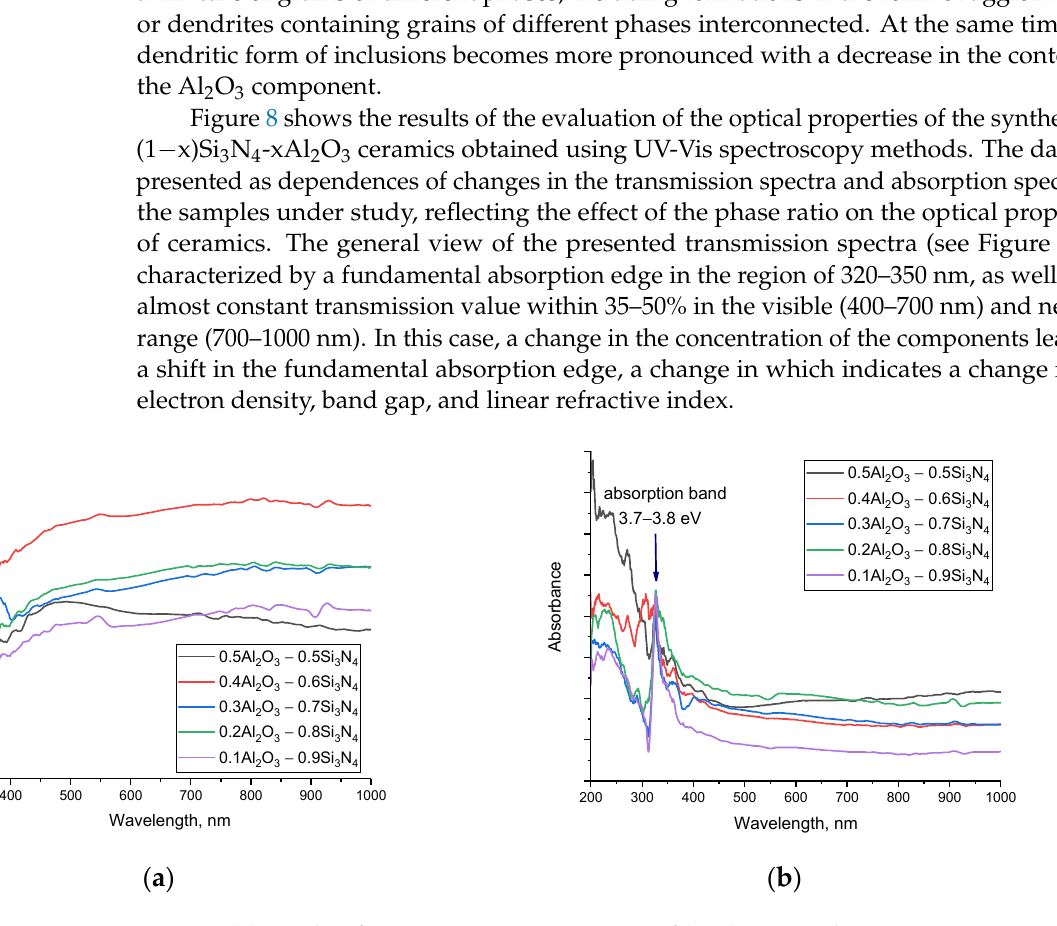
Table 1. Data on changes in optical characteristics.